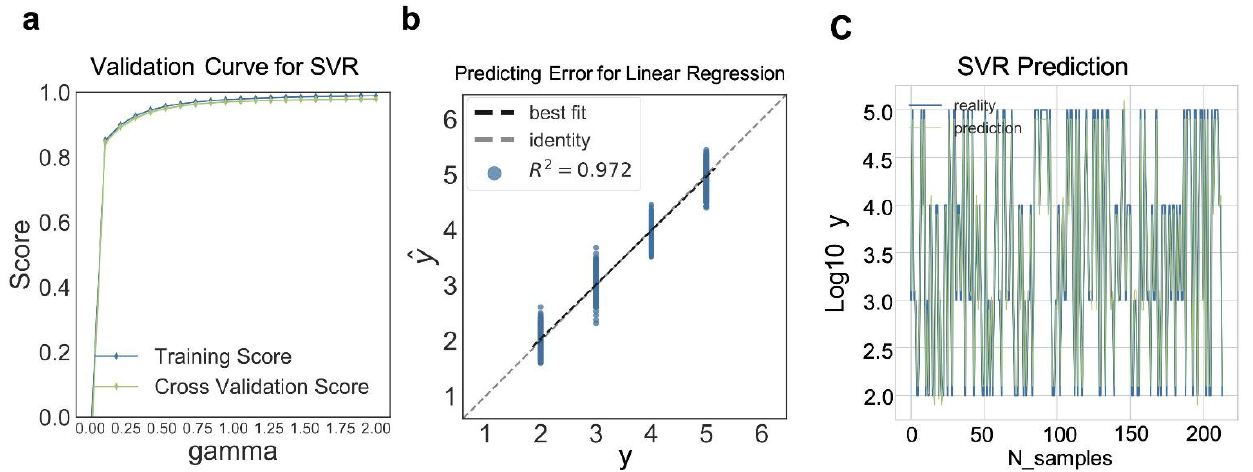
Figure 5. Accurate machine learning regression models can be obtained from training multiple features. ( a ) Validation curve for SVM regressor with increasing gamma (the blue curve stands for training scores, while the green curve stands for cross validation scores). ( b ) Prediction error for SVM regressor (the black line stands for best fit line while the gray line stands for identity line (R 2 = 0.972)). ( c ) Prediction of SVM regressor (The blue line stands for reality, while the green curve stands for prediction, N_sample = 214).